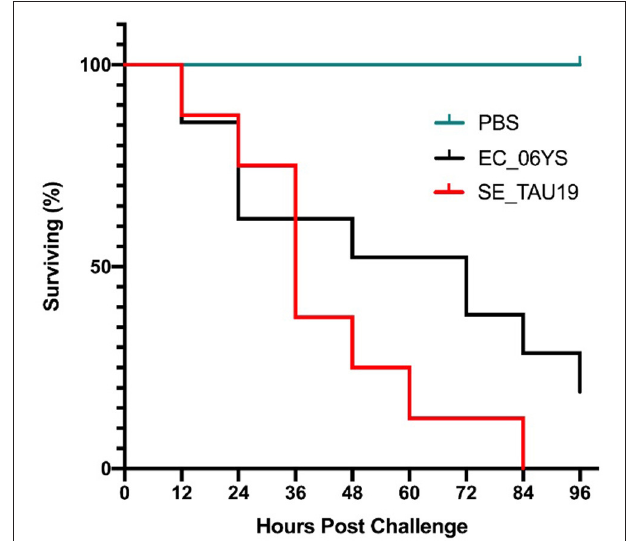
FIGURE 2 | Survival of broiler embryos after challenge with Salmonella Enteritidis strain SE_TAU19. An avian pathogenic E. coli strain known to be virulent to broiler embryos, EC_06YS, was used to challenge 21 eggs and served as a positive control. Eight broiler embryos were challenged with SE_TAU19. Eggs were inoculated with approximately 200 CFU/egg via the intra-allantoic route at 12 days of incubation and candled every 12h to monitor survivability. All embryos challenged with SE_TAU19 were dead by 84h, while the six PBS-injected control eggs survived and EC_06YS achieved expected